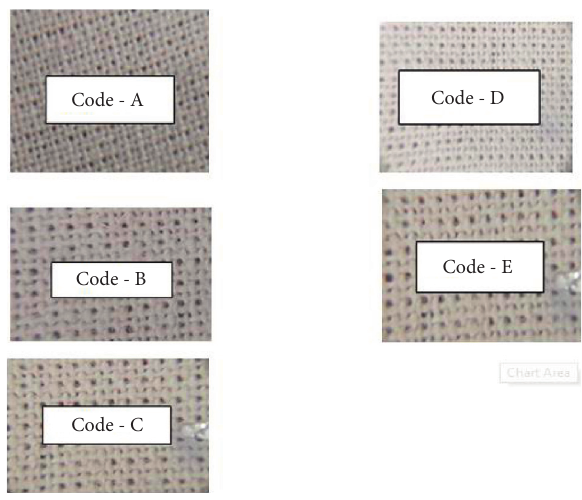
Figure 2: Fabric